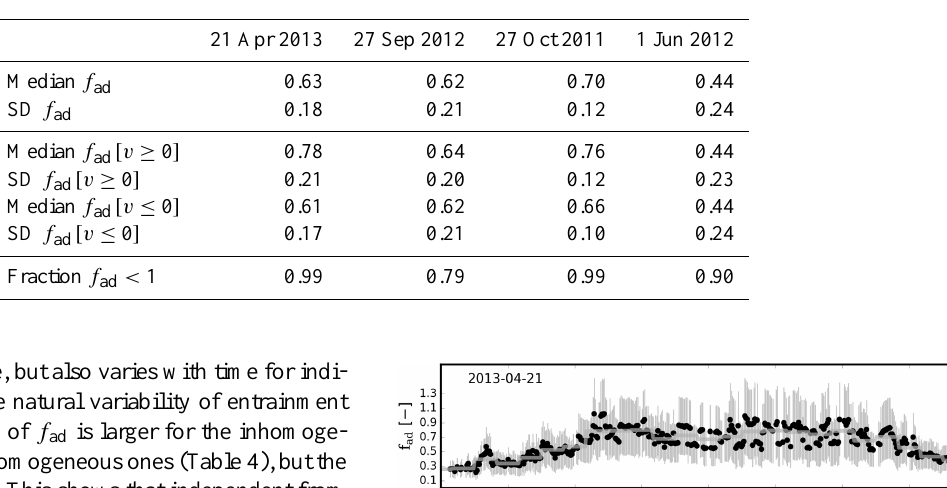
Table 4. Median and standard deviation of f ad (calculated from Eq. 2) for individual cases. Furthermore the median of f ad , classified into updraft ( v ≥ 0) and downdraft ( v < 0) regimes, as well as the fraction of sub-adiatic cloud profiles is shown. Values of f ad > 1 . 0 are omitted because those are likely affected by measurement uncertainties.